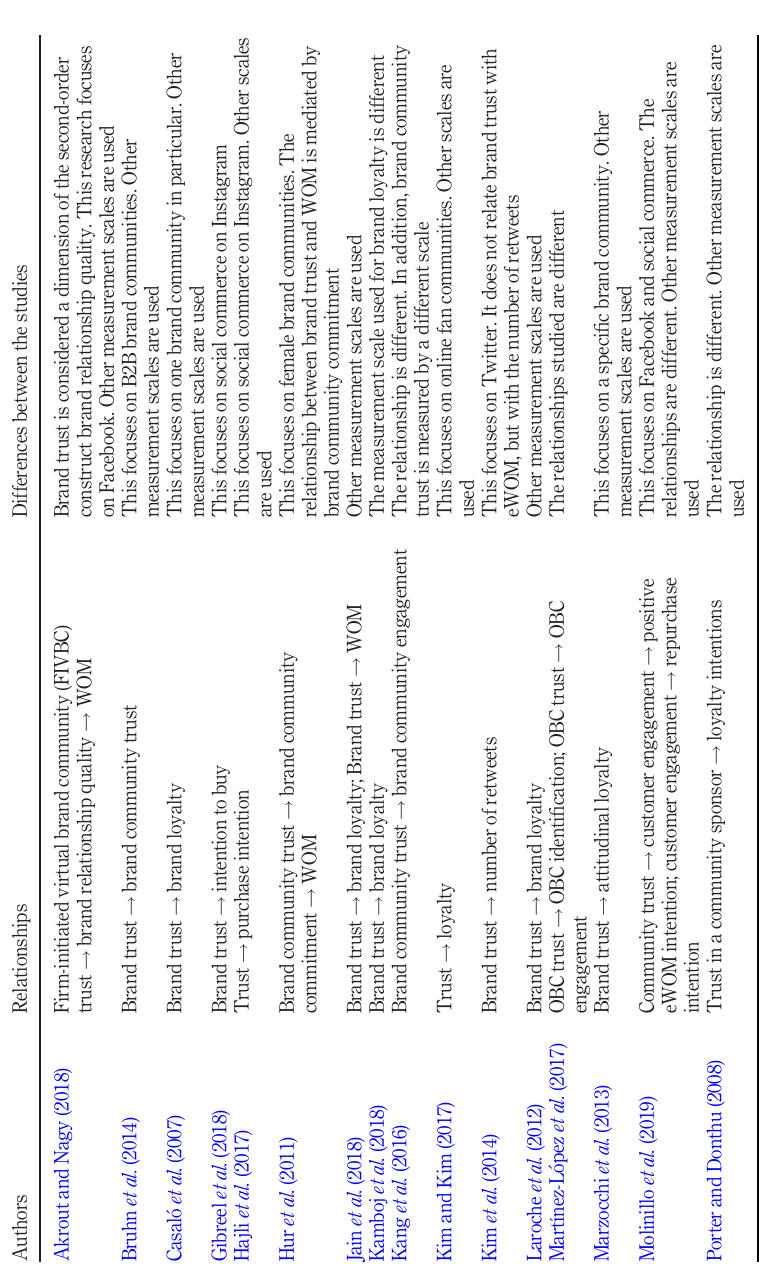
Table A1. Originality of